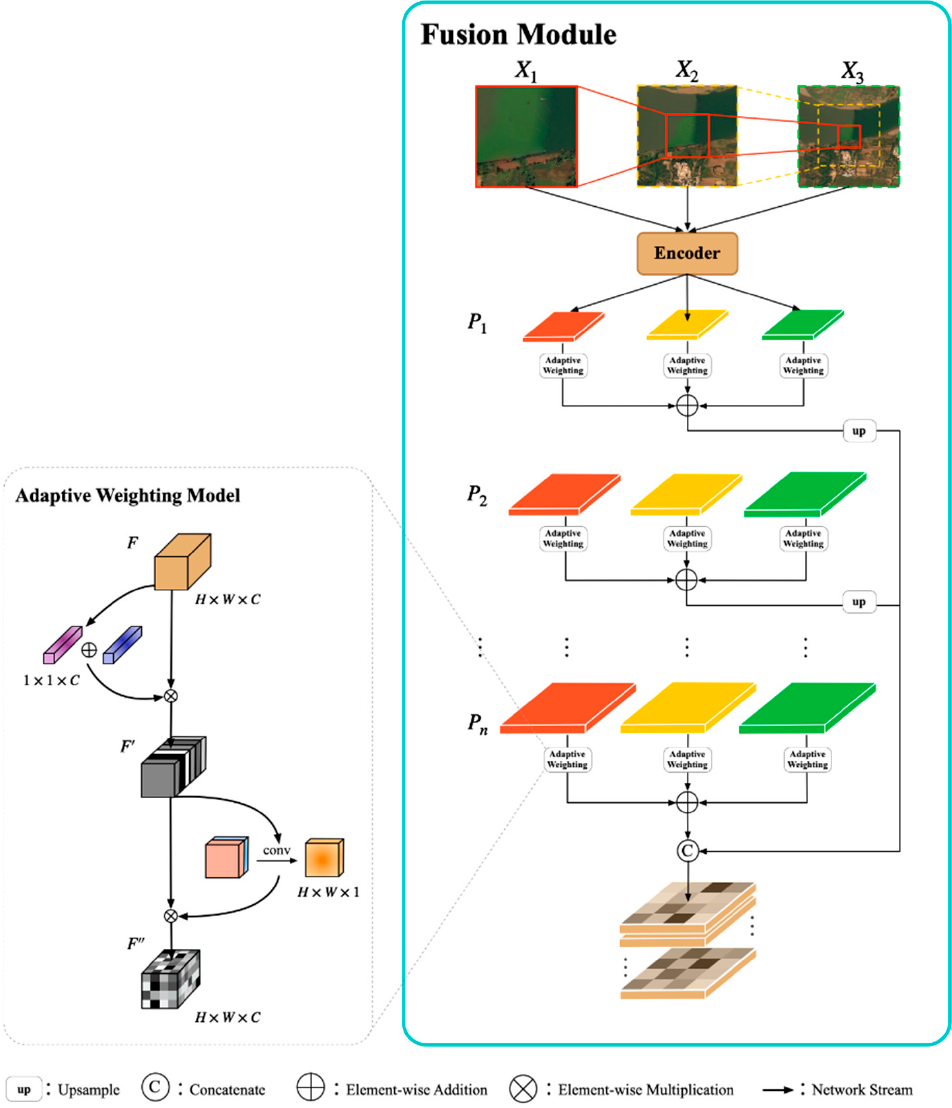
Figure 4. The multi-field context fusion module. FM adaptive fusion of multi-field semantic for local patch selected by PSM.